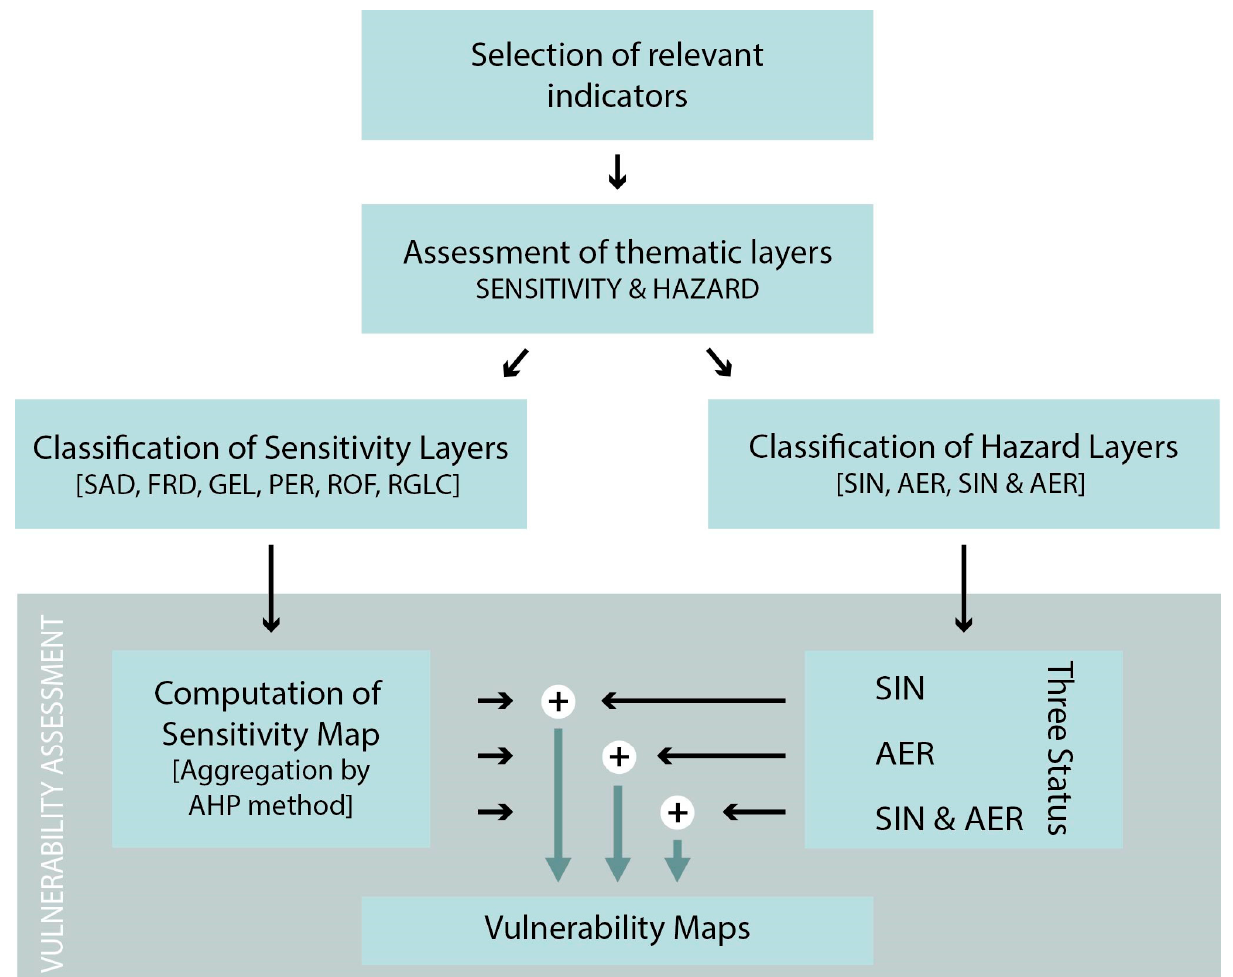
Figure 3. Workflow of the approach adopted to compute vulnerability